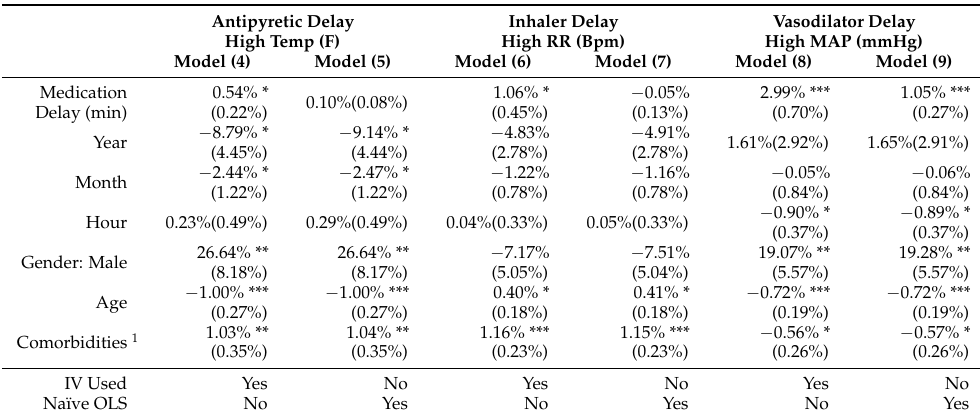
Table 5. Table of second stage regression results with and without instrumental variables showing the impact of medication delays on the patient health states as measured by vital signs (for antipyretics, inhalers, and vasodilators). Antipyretic Delay High Temp (F) Model (4) Model (5) Model (6) Model (7) Model (8) Model (9) Medication 0.54% * Delay (min) (0.22%) 0.10%(0.08%)